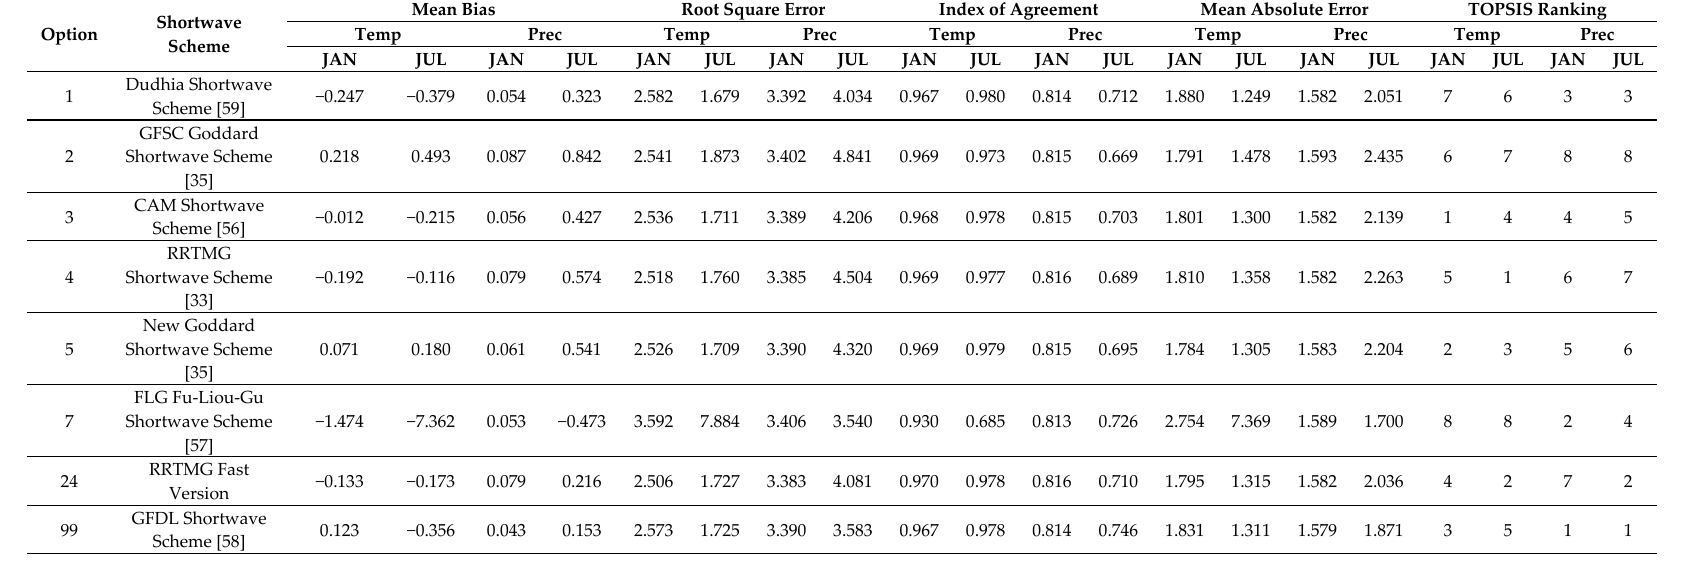
Table 6. Statistical measures and TOPSIS ranking for the Shortwave Radiation simulation group.